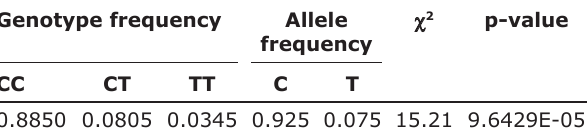
Figure-3: Genotyping of the pleomorphic adenoma gene 1 based on the g.48308 C>T single-nucleotide polymorphism. M is the 100 bp marker ladder, CC represents Bali cattle with the CC genotype, CT represents Bali cattle with the CT genotype, and TT represents Bali cattle with the TT genotype. Table-2: Allele and genotype frequencies of the g.48308 C>T single-nucleotide polymorphism of pleomorphic adenoma gene 1.